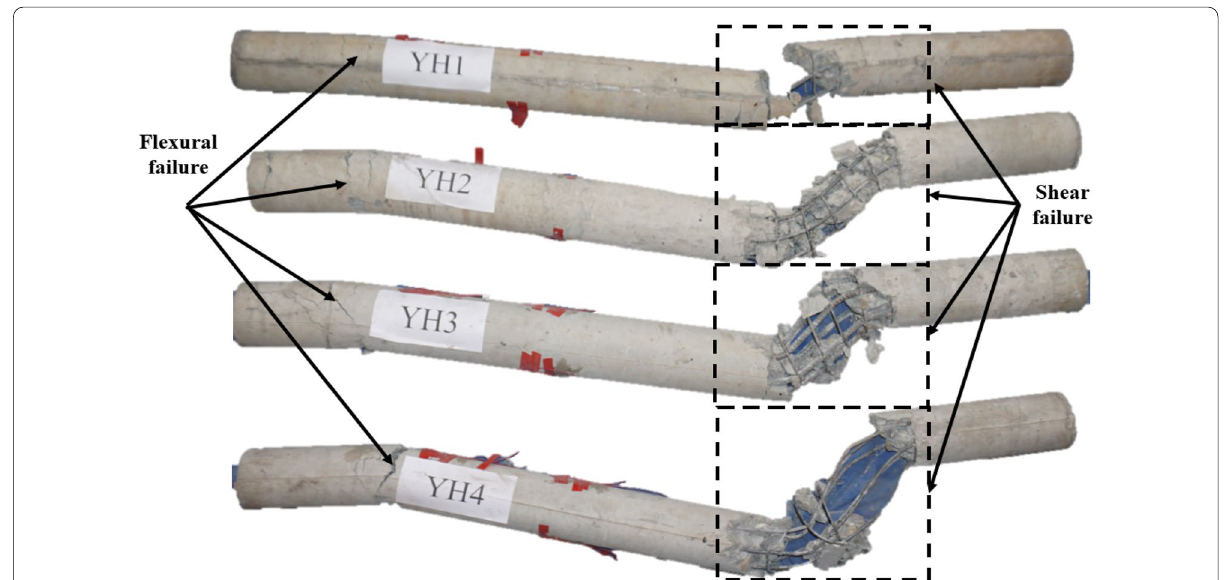
Fig. 12 Failure modes after the end of the impact scenario for